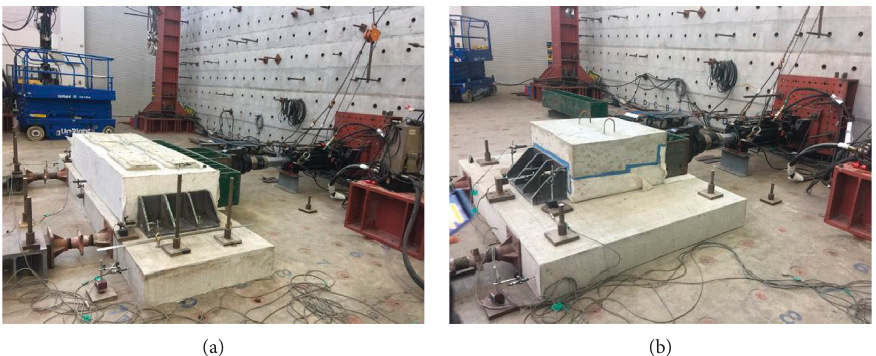
Figure 9: Test setup: (a) Specimen AL and (b) Specimen AT.